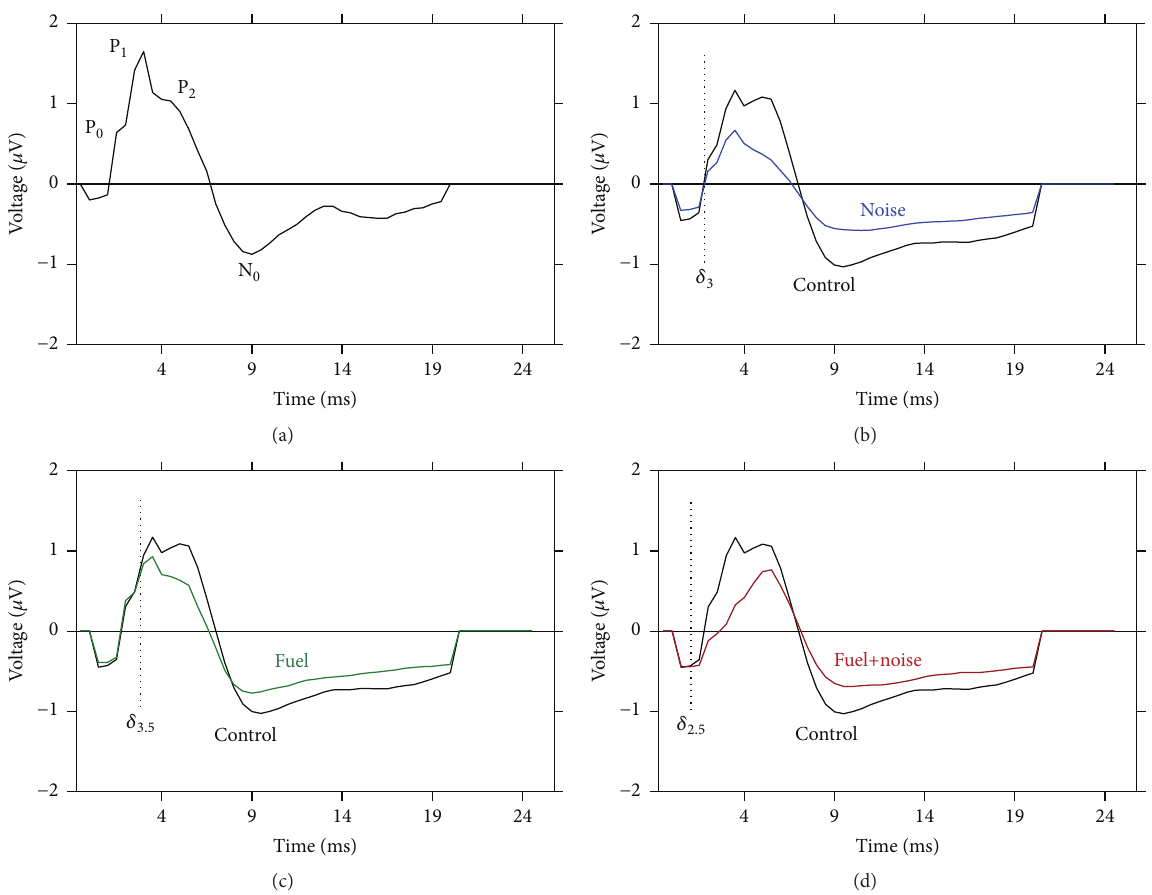
Figure 2: Abnormal SVP. (a) A typical SVP with three positive components (P 0 , P 1 , and P 2 ) followed by a negative component (N 0 ). (b) Grand average SVP from the control group compared with that from the noise exposed group. Note that the noise exposure suppressed the amplitude of P 1 , P 2 , and N 0 which resulted in a truncated waveform. (c) Similar, but less severe outcomes were observed after fuel-only exposure. (d) Combined exposure to both the fuel and noise resulted in a loss of P 0 and P 1 combined with suppression of P 2 and N 0 . Furthermore, the overall waveform is truncated. The vertical dotted lines demark the point in time where the instantaneous voltage trace deviated ( 𝛿 ) from normal. Note that fuel+noise exposure exhibited the earliest deviation at 2.5 ms. These instantaneous voltage traces were recorded with a 70 dB SPL rectangular voltage